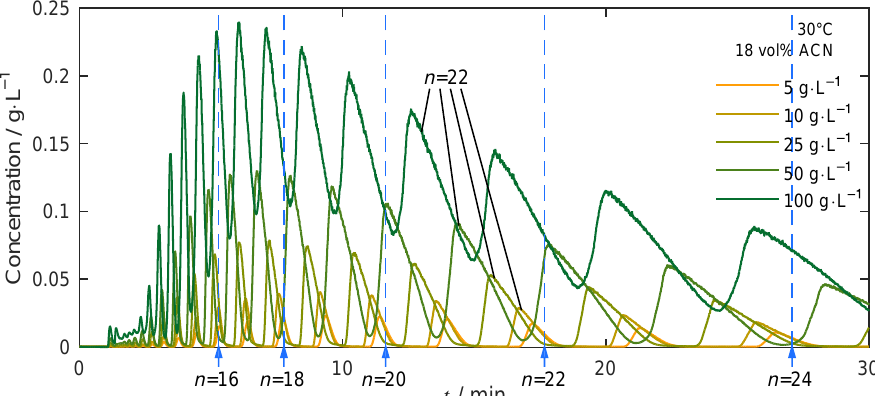
Figure 8. Overloading series under isocratic conditions for the preparative column. Overlay of five chromatograms with increasing injection concentrations ranging from 5 to 100 g/L (see legend) at an injection volume of 500 µ L, corresponding to injected amounts between 2.5 mg and 50 mg. For better orientation, the elution profiles for homolog n = 22 are marked. For comparison, the blue dashed lines mark the limiting retention times of the selected homologs for small injections calculated from the thermodynamic model. Measured at 18 vol% ACN and 30 ◦ C, the injection solvent is